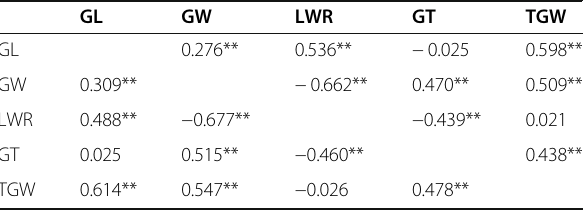
Table 2 Coefficients of pairwise correlation among five grain size traits in the F 2 and F 2:3 populations